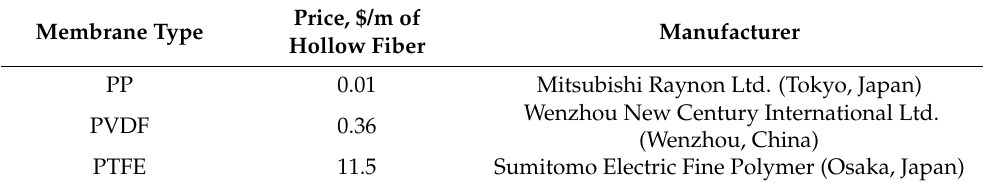
Table 5. Indicative cost of commercial polymeric hollow fiber membranes. Membrane